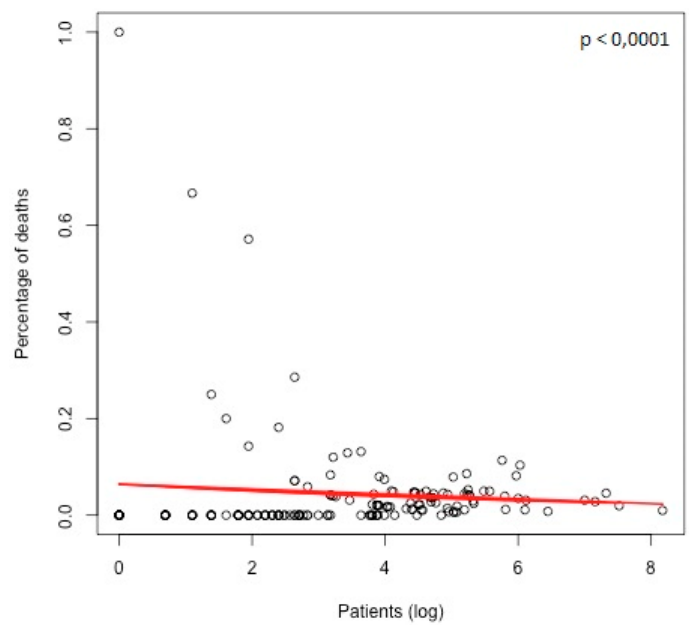
Figure 5. Graphic demonstration of the relationship between center volume (as patients, plotted in logistic scale) and the percentage of death. A significant inverse relationship was found between the two variables. The red line represents the logistic regression model estimated.